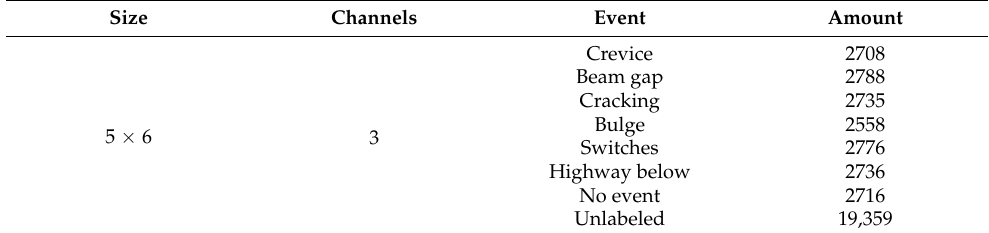
Table 3. Training set for classification model training generated from the balanced overall